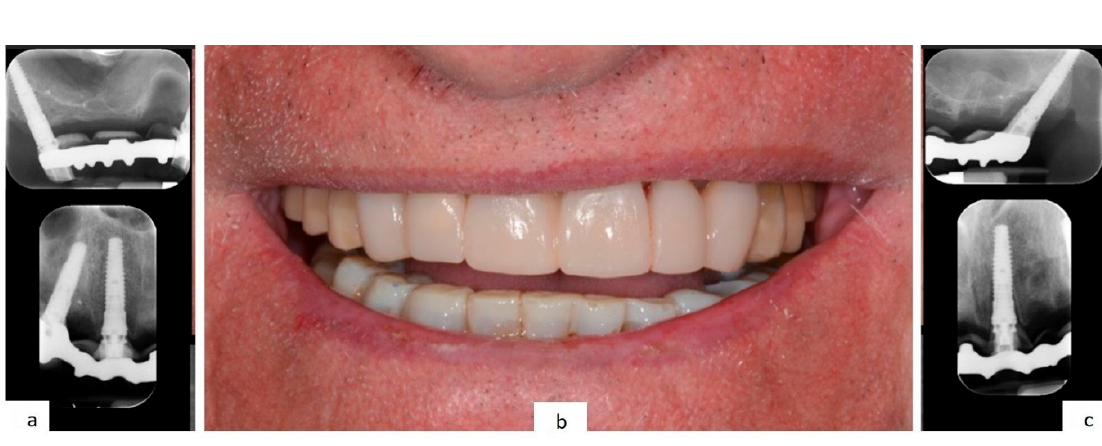
Figure 7. The temporary prosthesis delivered 24 h after surgery ( b ), with the X-rays check of the prosthetic framework fitting ( a , c ).